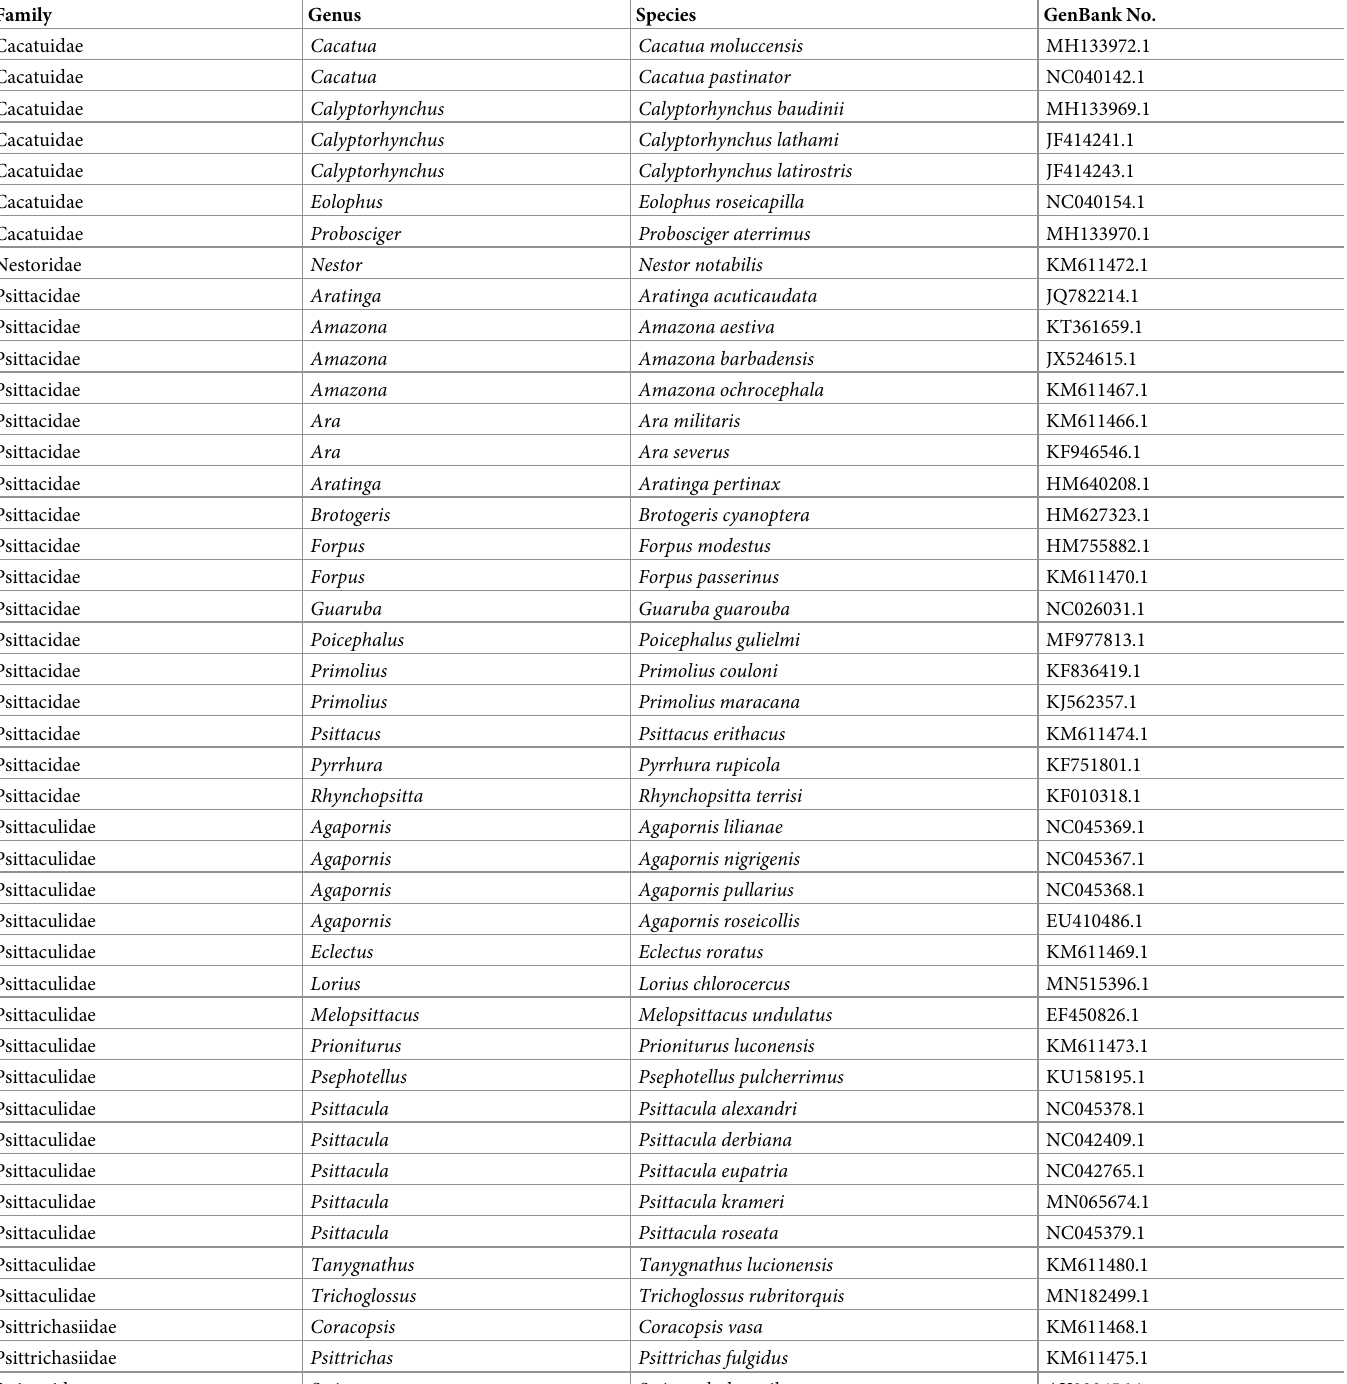
Table 1. List of the 44 Psittaciformes species used for comparative analysis in this study with their GenBank accession numbers.